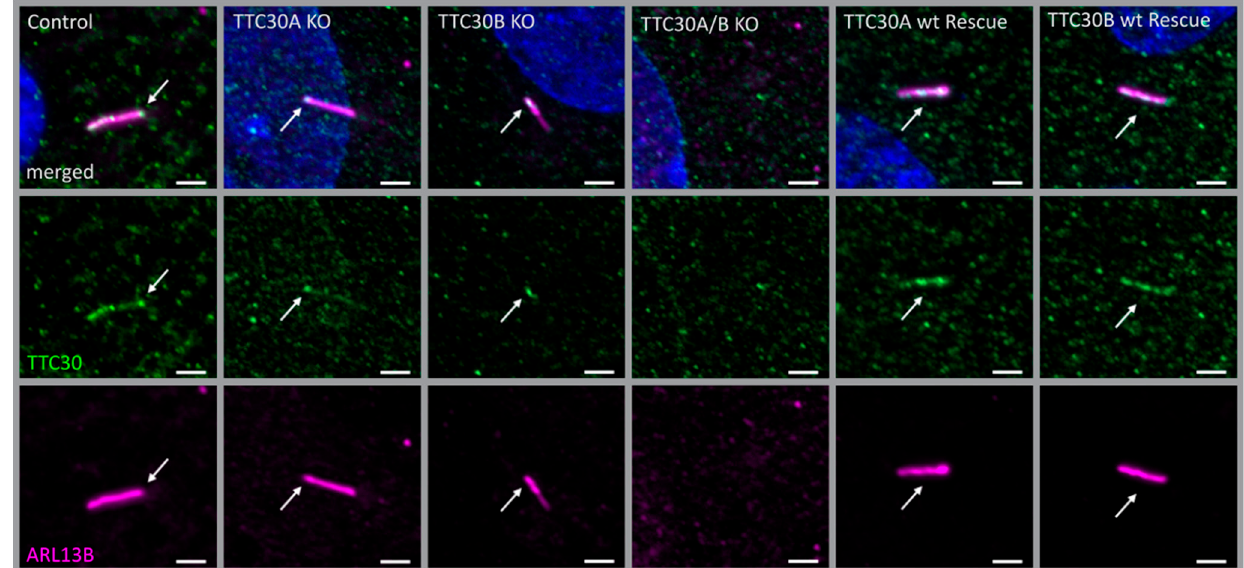
Figure 2. Fluorescent light microscopy pictures of hTERT-RPE1 control, TTC30A, TTC30B and TTC30A/B double-KO cells, TTC30A and TTC30B rescue (from left to right) are shown. The cells were stained for ARL13B (magenta) and TTC30 (green), DNA is marked in dark blue and co-localization shown in white. The scale bar measures 2 µm.